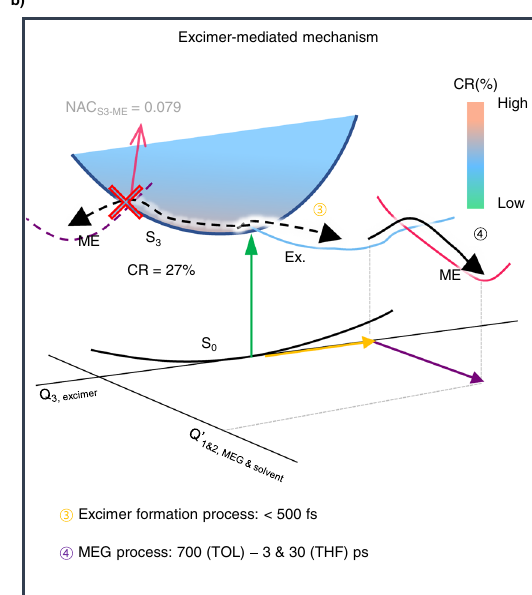
Fig. 6 | Schematic illustrations ofmultiexciton generationpathways by theHP and LP. The (virtual)CT-mediated mechanism by LP( a ) and the excimer-mediated (orrealCT-mediated)mechanismbyHP( b ).TheNAC Sn-ME andCRcon fi gurationsin the S n states are estimated by RAS-3SF simulations (see Supplementary Table 7).